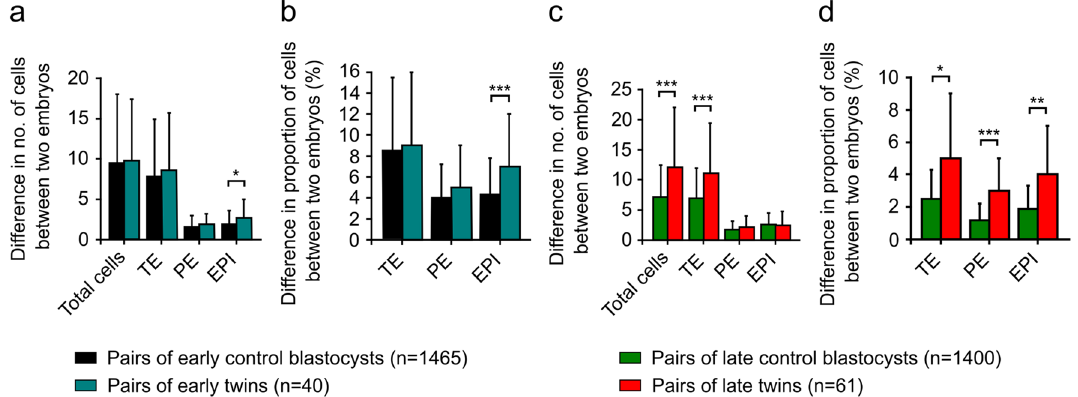
Figure 4. Cell lineage analysis of pairs of early and late twin blastocysts. ( a ) The mean difference in the total number of cells, the number of TE cells, as well as the progenitors of EPI and PE between the pairs of early twin blastocysts. ( b ) The mean difference in the percentage of TE cells, as well as the progenitors of EPI and PE between the pairs of early twin blastocysts. ( c ) The mean difference in the total number of cells, as well as the numbers of TE, PE, and EPI cells between pairs of late twin blastocysts. ( d ) The mean difference in the percentage of TE, PE, and EPI cells between the pairs of late twin blastocysts. For ( a , b , c , and d ), normality